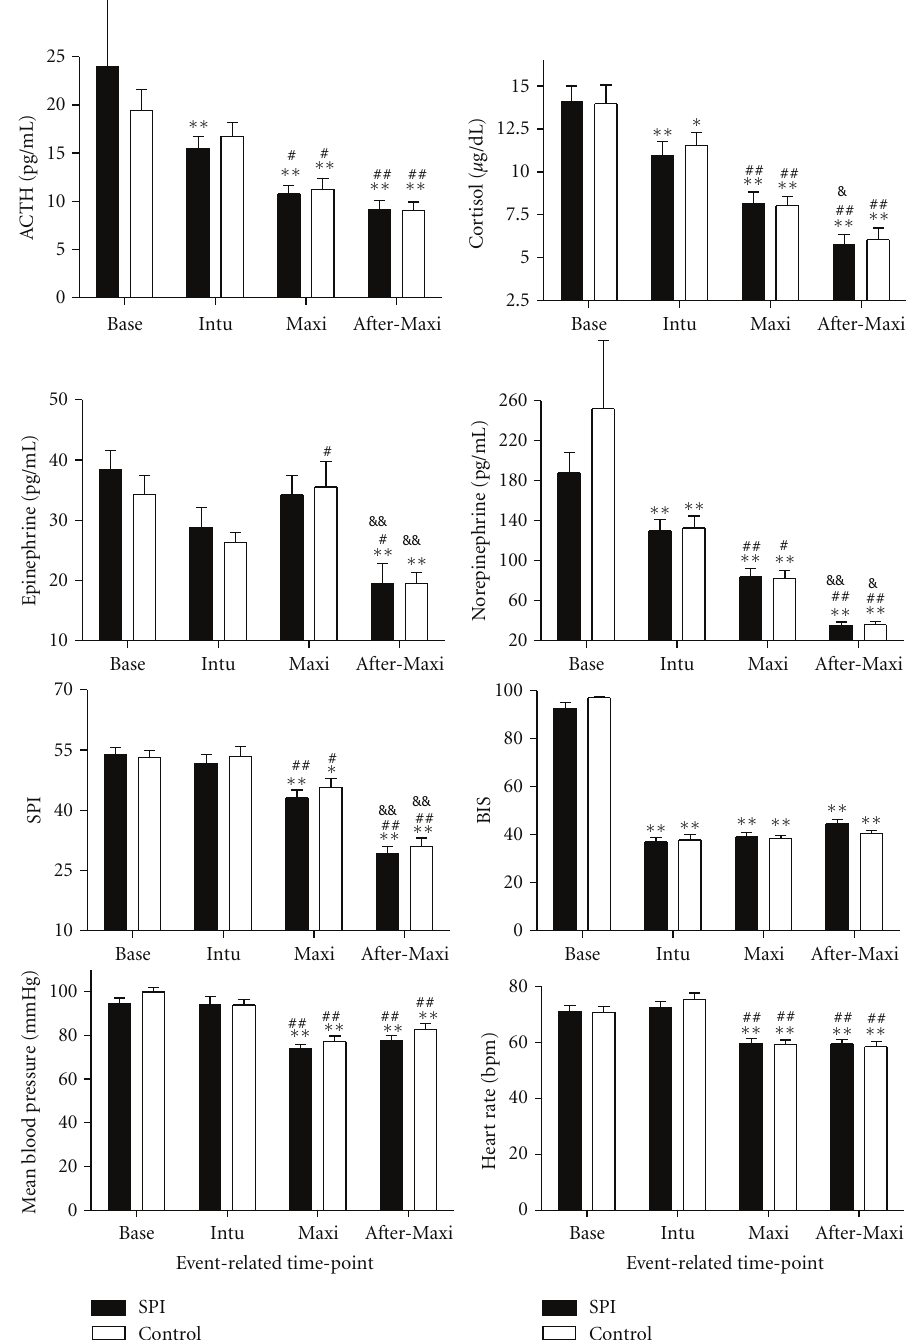
Figure 1: Values are mean ± SD. Base: baseline before anaesthesia; Intu: after tracheal intubation; Max: at maximum operative trauma which was defined intraoperatively by the surgeon; After-Max: 15 min after the maximum operative trauma; Mean: mean blood pressure; HR: heart rate; SPI: the group in which remifentanil administration was guided by SPI; Control: the group in which remifentanil administration was guided by standard traditional inadequate anaesthesia criteria. ∗ P < 0 . 05, ∗∗ P < 0 . 01 compared with respective values at Base in the same group with one-way ANOVA followed by LSD test. # P < 0 . 05, ## P < 0 . 01 compared with respective values at Intu in the same group with one-way ANOVA followed by LSD test. & P < 0 . 05, && P < 0 . 01 compared with respective values at Maxi in the same group with one-way ANOVA followed by LSD test. No di ff erences were found between the SPI group and the Control group at all four event-related time points ( P > 0 .